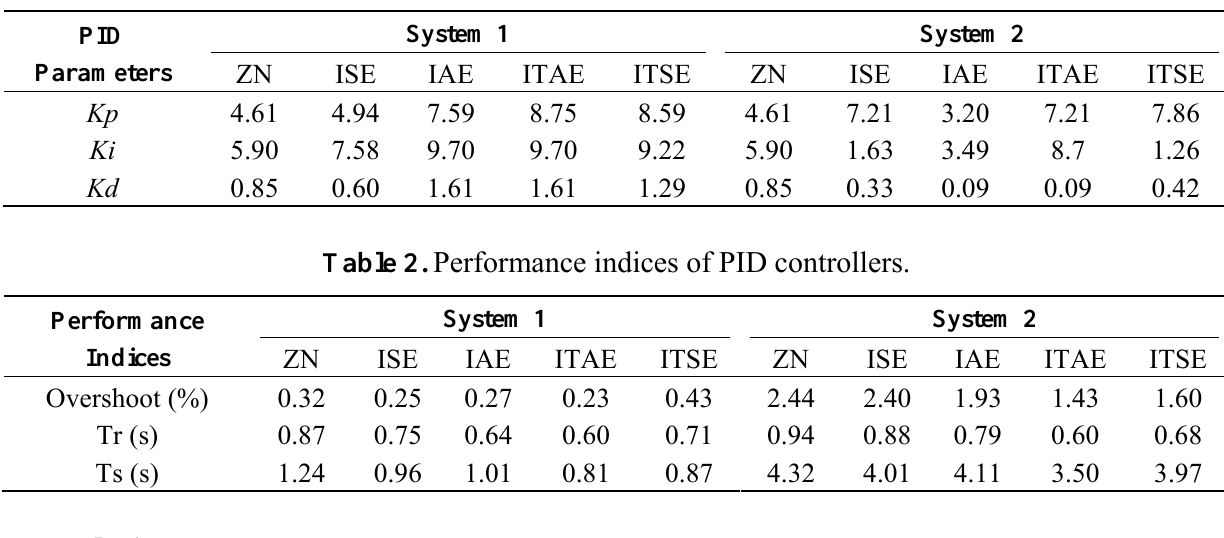
Table 1. Tuned parameters of PID controllers.